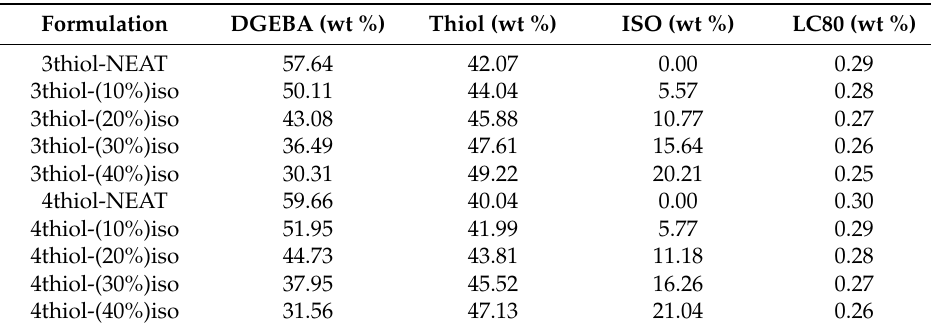
Table 1. Composition of the different formulations of study.